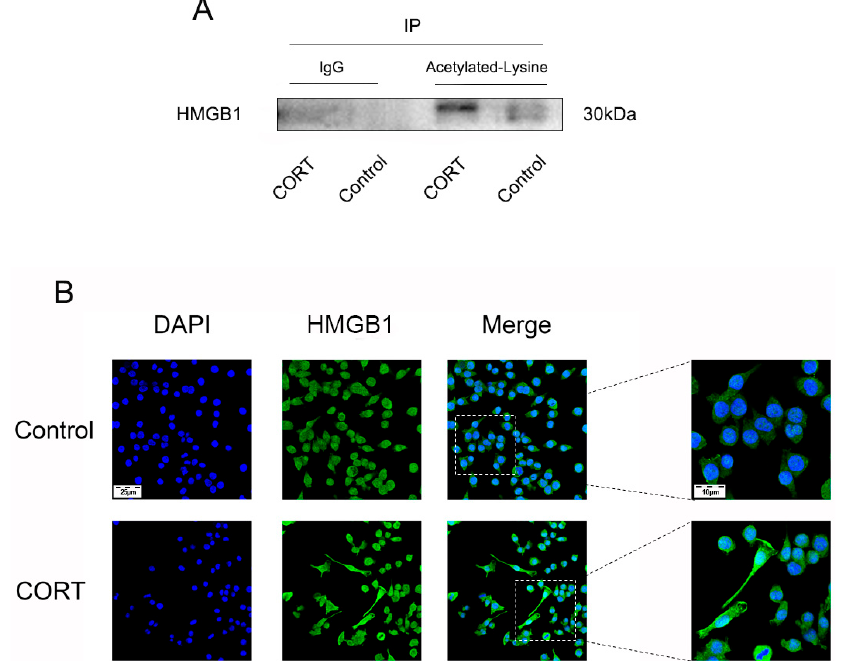
Figure 14. High-mobility group box (HMGB)1 acetylation level and protein localization in cortisol (CORT)-treated BV2 cells. ( A ) Co-immunoprecipitation (Co-IP) of acetyl-Lys with HMGB1 from BV2 cells with or without CORT treatment (200 µ M) for 3 h. Right to left, immunoprecipitates obtained with acetyl-histone H3 (Lys9) antibody (lanes 1 and 2) or control IgG (lanes 3 and 4) were probed with an anti-HMGB1 antibody. ( B ) HMGB1 protein localization in BV2 cells, as detected by immunocytochemistry.